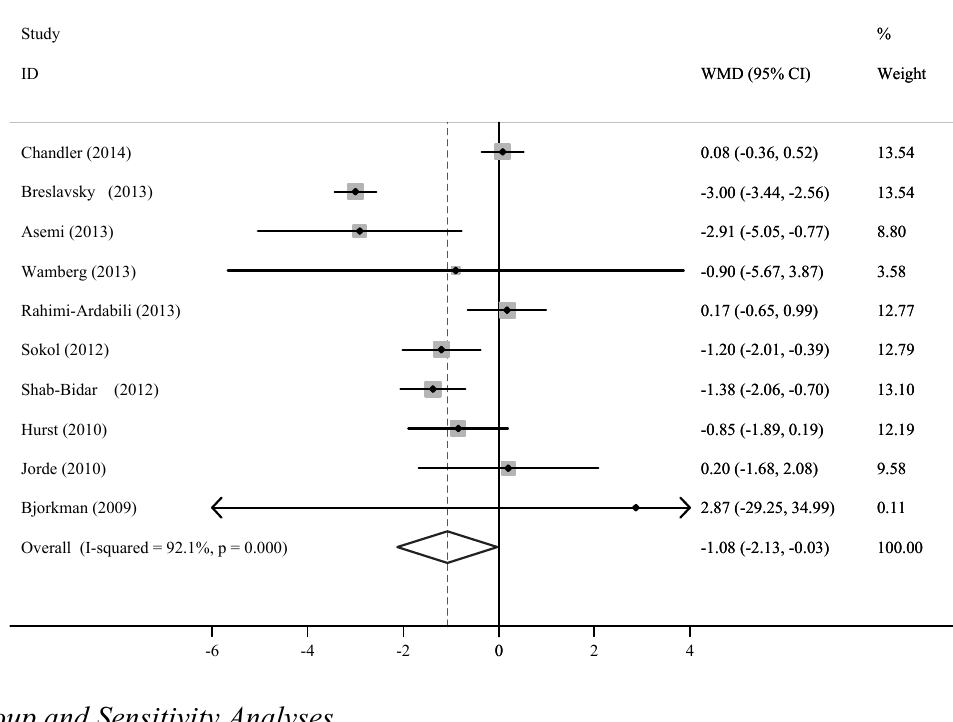
Figure 2. Meta-analysis of trials on vitamin D supplementation and circulating high-sensitivity C-reactive protein (hs-CRP) level.